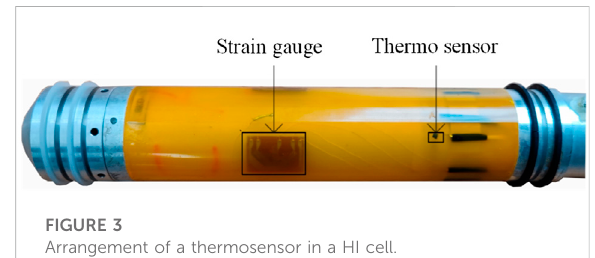
FIGURE 3 Arrangement of a thermosensor in a HI cell.